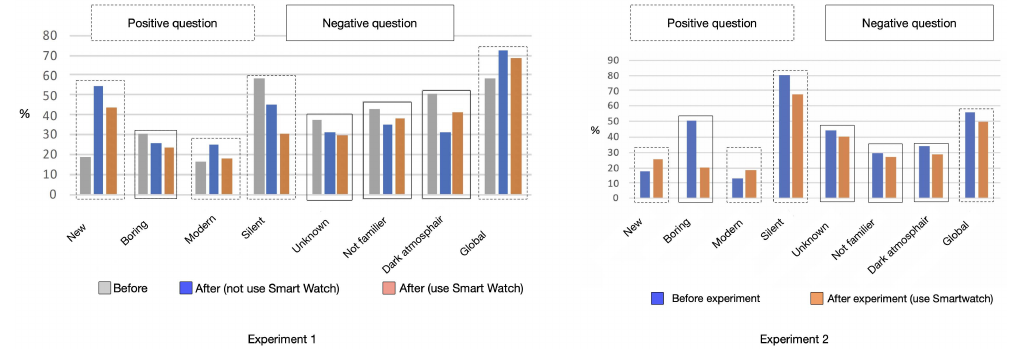
Figure 23. Change of image of